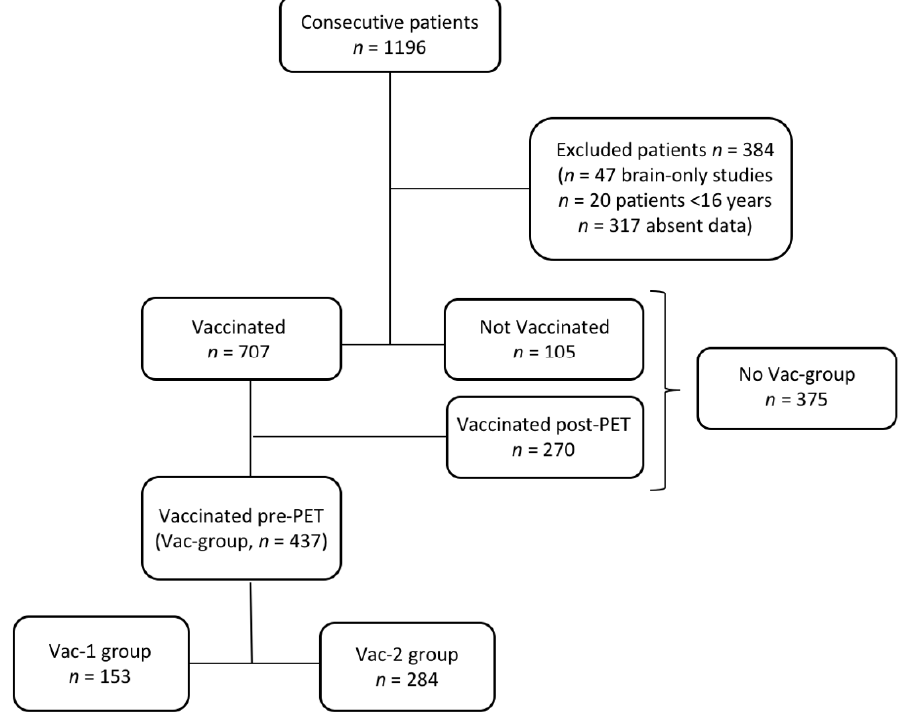
Figure 1. Patients flow chart. Table 1. Demographic characteristics of the vaccinated study